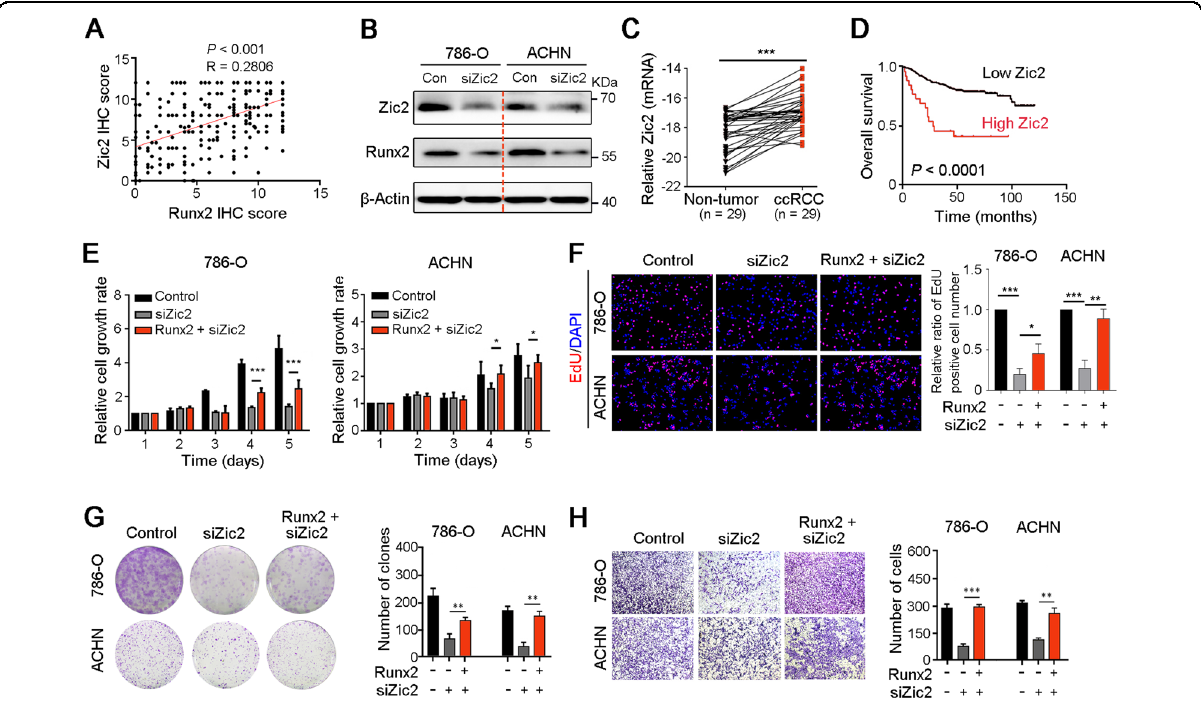
Fig. 5 Zic2 upregulates the expression of Runx2 promoting ccRCC cell growth and metastasis. A IHC staining analysis in ccRCC tissue array showed the positive correlation of Zic2 and Runx2 expressions. B Western blot analysis showed the downregulation of Runx2 in 786-O and ACHN cells after knockdown of Zic2. β -Actin was also tested as a loading control. C qRT-PCR was used to analyze the expression level of Zic2 in ccRCC and paired normal renal tissues ( n = 29). D Survival curves based on IHC staining indicated the poorer outcome of ccRCC patients with high expression of Zic2 than those with low level of Zic2 ( P < 0.0001). E – G MTT test ( E ), EdU incorporation ( F ), and foci formation ( G ) assays were performed to analyze the proliferation of 786-O and ACHN cells after knockdown of Zic2 or/and Runx2 overexpression, respectively. H The migration ability of ccRCC cells after interference of Zic2 or/and overexpression of Runx2 was tested by Transwell migration assay. In all panels, *, P < 0.05; **, P < 0.01; ***, P <